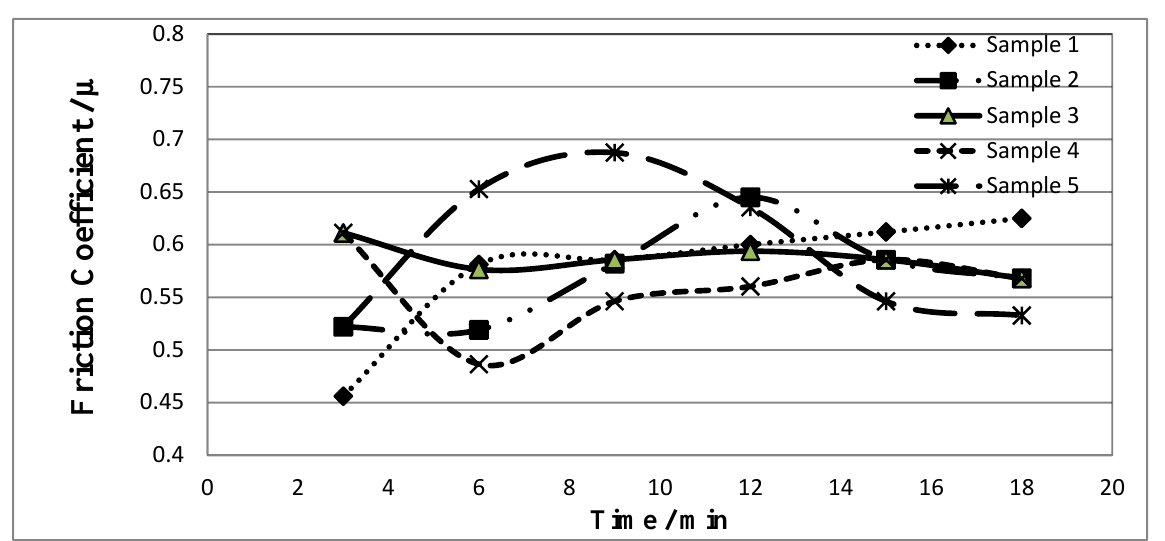
Figure 9. Variation of friction coefficient with test duration.